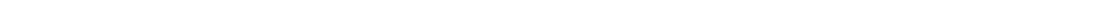
Fig. 5 CsrA regulates extracytoplasmic stress responses. a Summary of CsrA effects on expression of cell envelope-related genes. The signaling cascade that leads to release of RpoE 79 is shown surrounded by a red box. The presence of misfolded outer membrane proteins (OMPs) (1a) stimulates DegS proteolytic activity toward RseA (2). LPS also promotes release of RseB to reveal a DegS sensitive site in RseA (1b). After DegS cleavage, RseP cleaves the transmembrane domain of RseA (3). Finally, cytoplasmic ClpXP protease degrades the cytoplasmic portion of RseA (4), thus releasing RpoE from the membrane and allowing it to activate transcription of genes for the envelope stress response (5). Squares near gene names show effect of CsrA on translation (RPF, left), RNA abundance (RNA, top), RNA stability (stability, bottom), and/or translation ef fi ciency (TE, right). Purple indicates repression by CsrA and green indicates activation. Asterisks indicate that CsrA CLIP-seq peak(s) are associated with the gene. b 3xFLAG-CsrA and untagged control CLIP-seq read counts mapped to the rpoE - rseA locus. Position of electrophoretic mobility shift assay (EMSA) probes are indicated by boxes below the plot. c EMSA showing of 6xHis-CsrA- rpoE RNA interaction ( − 133 to +19 nt relative to the start codon). Apparent equilibrium binding constant ( K d ) is shown. d EMSA showing CsrA- rseA RNA interaction ( − 228 to − 1 nt relative to the start codon). Apparent K d value is shown. e β -galactosidase activity of a P rpoE rpoE ′ – ′ lacZ translational fusion in wild-type (WT) and csrA mutant strains grown in LB at 30 °C. Error bars show standard deviation from the mean of three independent experiments. Two tailed Student ’ s t test was used to determine statistical signi fi cance: EL early log ( n = 3, p = 0.006), ML mid-log ( n = 3, p = 0.0002), T transition to stationary ( n = 3, p = 0.0043), and S early stationary phase ( n = 3, p = 0.0017). f Growth of serial dilutions of WT and csrA